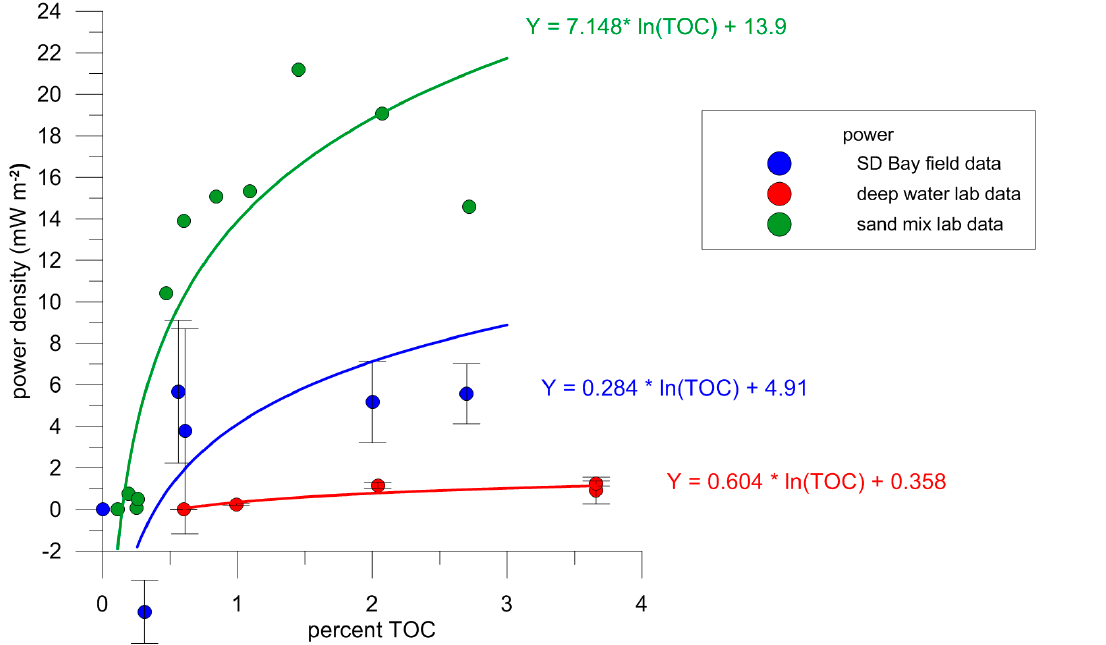
Figure 13. MFC power density from deep (red line) and shallow (blue and green lines) sediments normalized to 5 °C.